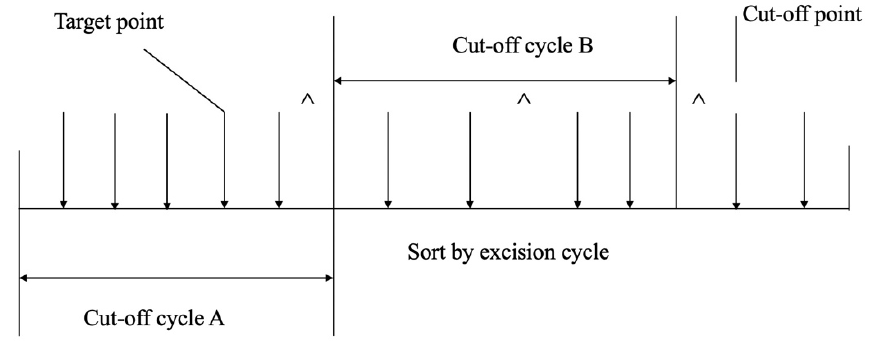
Figure 17. Network slice mapping mechanism on the time window line.